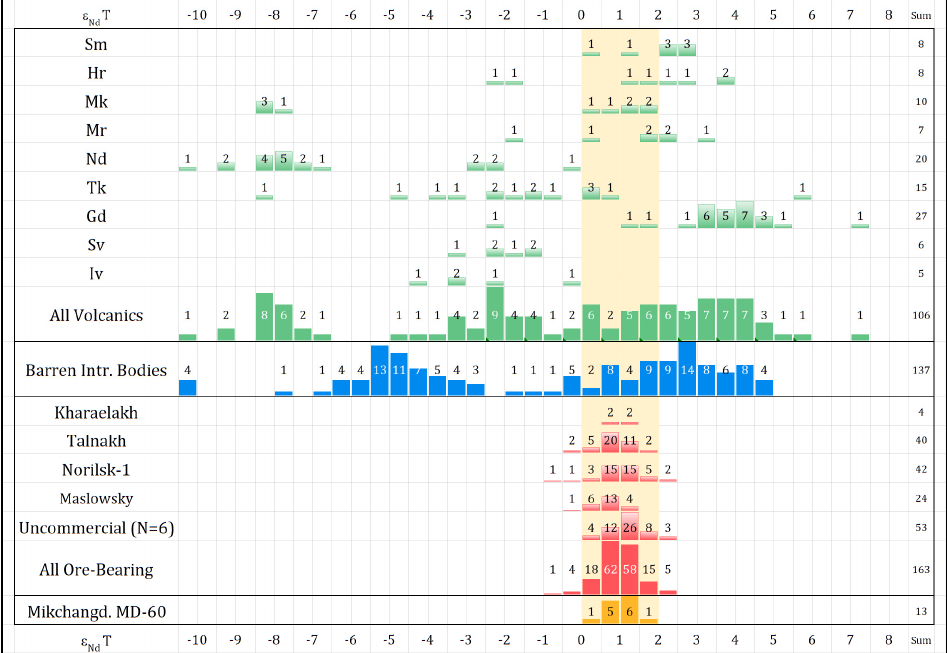
Figure 8. Histogram of the Nd isotopic composition ( Ԑ Nd T) in volcanic and intrusive rocks in the